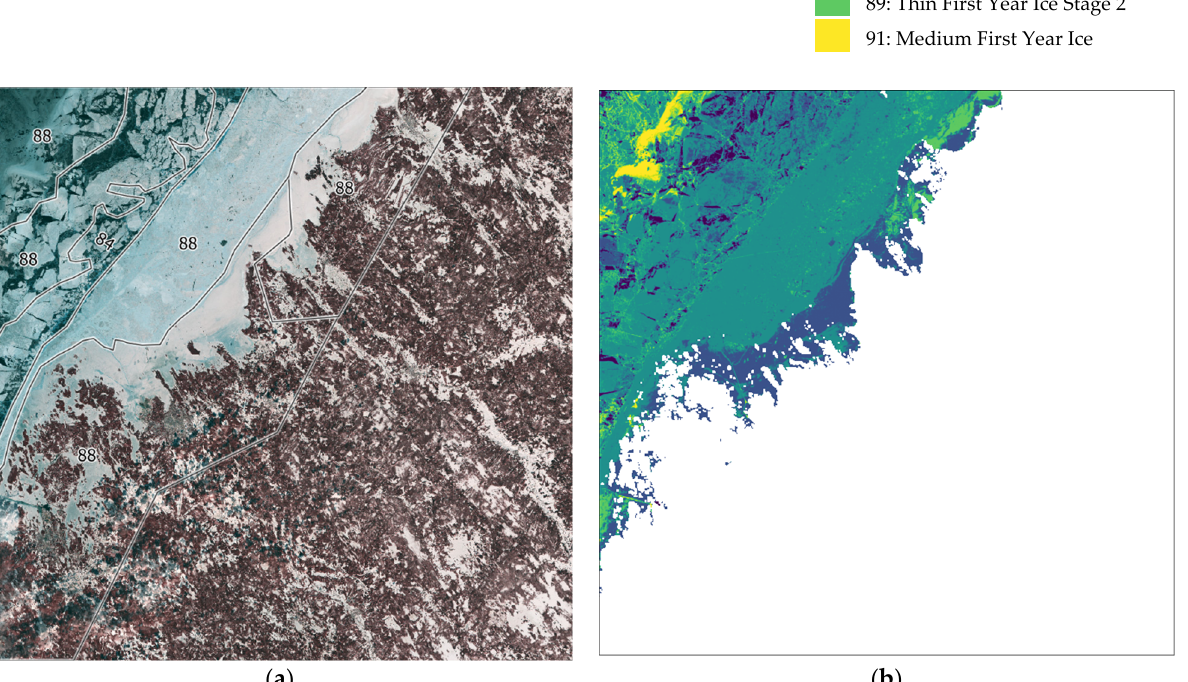
Figure 10. ( a ) Landsat-8 false color for 06 March 2019; BSH ice chart for 05 March 2019; ( b ) ICESOD classification.